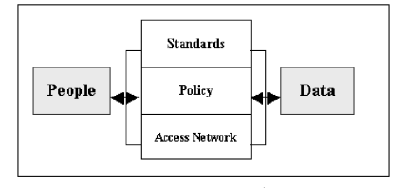
Figure 4. Components of SDI (source: [SRW06])